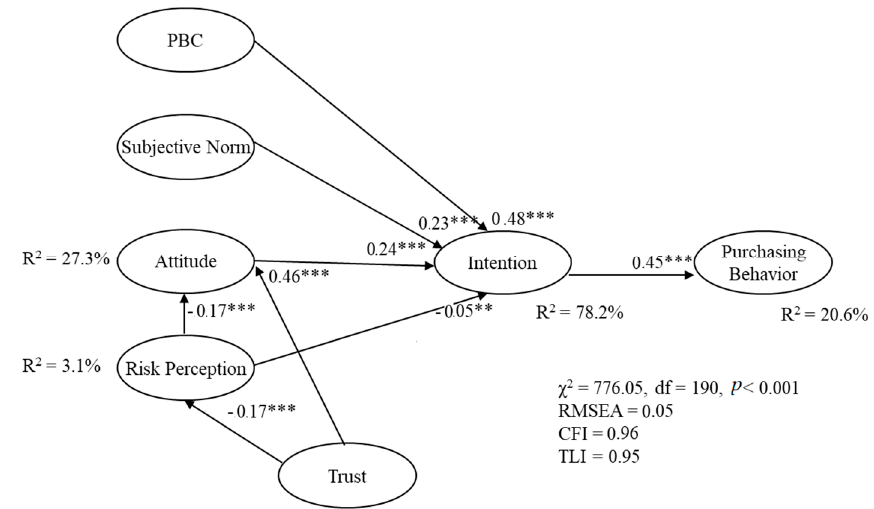
Figure 2. Path model with standardized regression coefficients and standard loadings. Note: *** p < 0.001; ** p < 0.05.